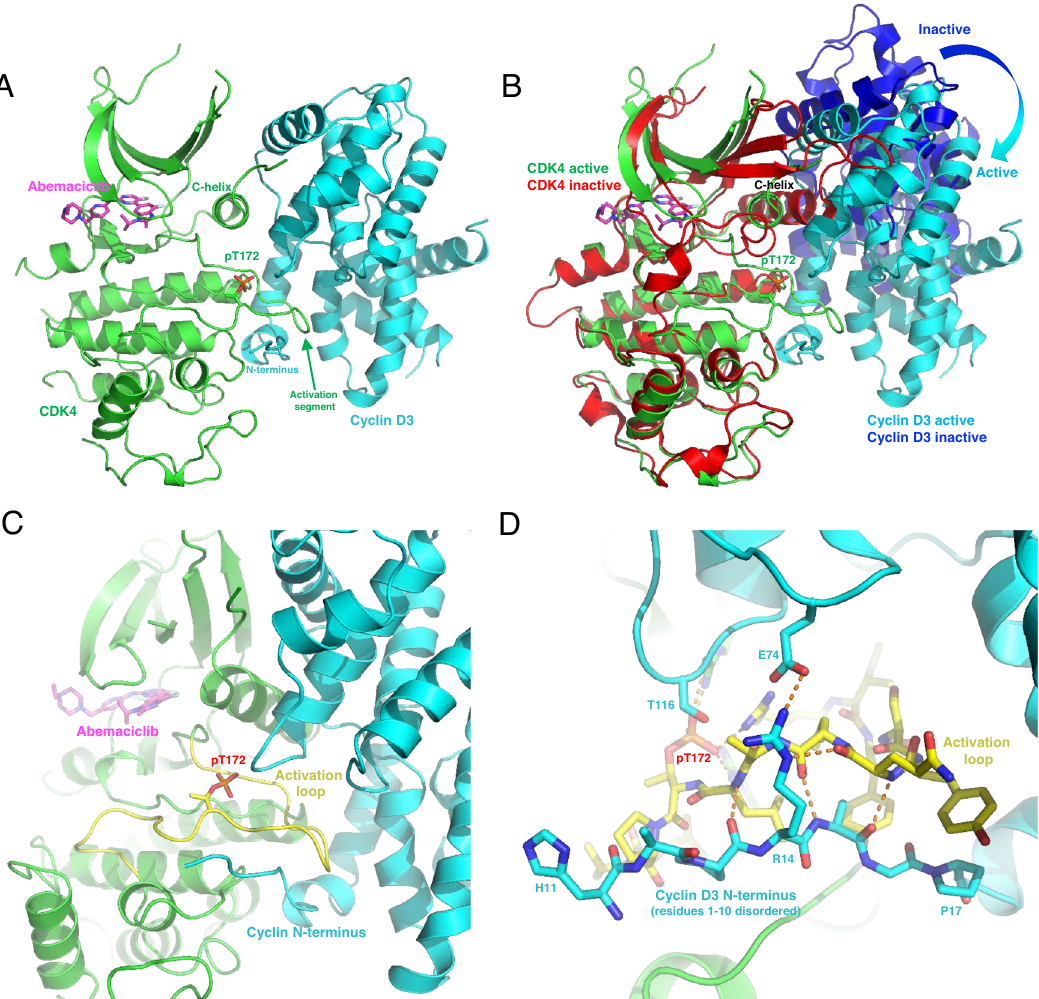
Fig. 1 Crystal structure of active CDK4-cyclin D3 complex with abemaciclib bound. A The phosphorylated (pT172) complex exhibits the hallmarks of kinase activation, including an “ out ” activation segment, appropriately oriented C-helix, and an active-site competent for ligand binding (abemaciclib shown in magenta). B An example of an inactive complex (3G33.pdb), superposed with the active complex, with relative rotation indicated. Note the smaller CDK4-cyclin D3 interface and disordered cyclin D3 N-terminus. Extensive interaction of the activation segment (yellow) with the cyclin N-terminus. C The cyclin D3 N-terminus (ordered after residue H11) buttresses the activation segment, playing a role in adoption of the active conformation. D The interactions between kinase and cyclin involve an extensive Hydrogen bond network, largely composed of peptide backbone interactions. Residues R14 and E74 form an “ electrostatic belt ” around the activation